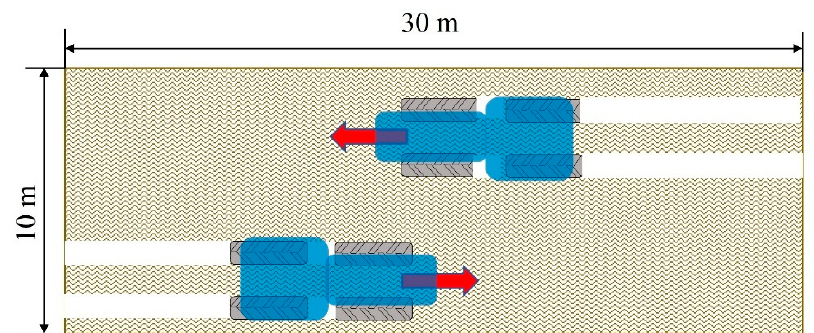
Figure 1. Single plot sizes with tracks made by the tractor.